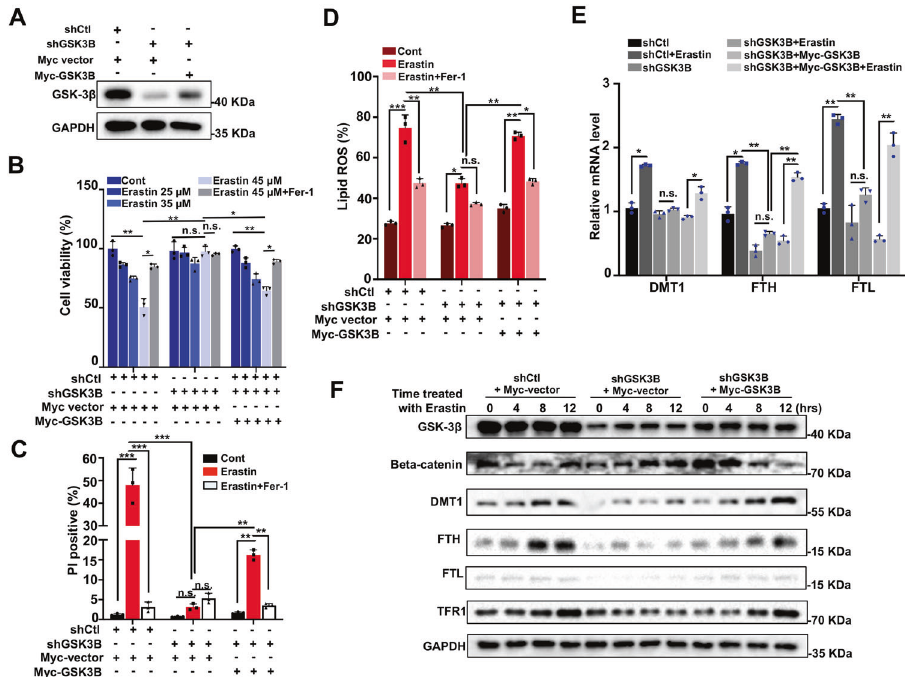
Fig. 5 Re-expression of GSK-3 β restores GSK-3 β depletion-resisted ferroptosis. A Indicated shCtl or shGSK-3 β HeLa cells were transfected with either control plasmid (myc-vector) or myc-GSK-3 β plasmid. Re-expression of GSK-3 β was con fi rmed by immunoblotting. B shCtl or shGSK-3 β HeLa cells transfected with myc-vector or myc-GSK-3 β were treated with erastin (35 μ M) with or without Fer-1 (20 μ M) for 24 h, cell viability was assayed using a CCK8 kit. C shCtl or shGSK-3 β HeLa cells transfected with myc-vector or myc-GSK-3 β were treated with erastin (35 μ M) with or without Fer-1 (20 μ M) for 24 h, and cell death was measured by propidium iodide (PI) staining using fl uorescence microscopy. The percentage of PI positive (red) cells were quantitated. Data shown represent mean ± SD from three independent experiments. D shCtl or shGSK-3 β HeLa cells transfected with myc-vector or myc-GSK-3 β were treated with erastin (35 μ M) with or without Fer-1 (20 μ M) for 24 h, and lipid ROS production was detected by fl ow cytometry using C 11 -BODIPY. The percentage of BODIPY-positive cells in C were quantitated. Data shown represent mean ± SD from three independent experiments. E shCtl or shGSK-3 β HeLa cells transfected with myc-vector or myc-GSK-3 β were treated with 35 μ M erastin for 24 h, and the mRNA expression of DMT1, FTH1, and FTL in indicated HeLa cells was assayed by RT-qPCR. The relative gene expression is normalized to GAPDH. Data shown represent mean ± SD from three independent experiments. F Indicated shCtl, shGSK-3 β , and shGSK-3 β transfected with myc-GSK-3 β HeLa cells were treated with 35 μ M erastin for different times (0, 4, 8, 12 h) as indicated, and subjected to Western blotting for GSK-3 β , pGSK-3 β (Ser9), beta-catenin, DMT1, FTH, FTL, and TFR1. Statistical analysis was made using Student ’ s t -test; * p < 0.05, ** p < 0.01, *** p <